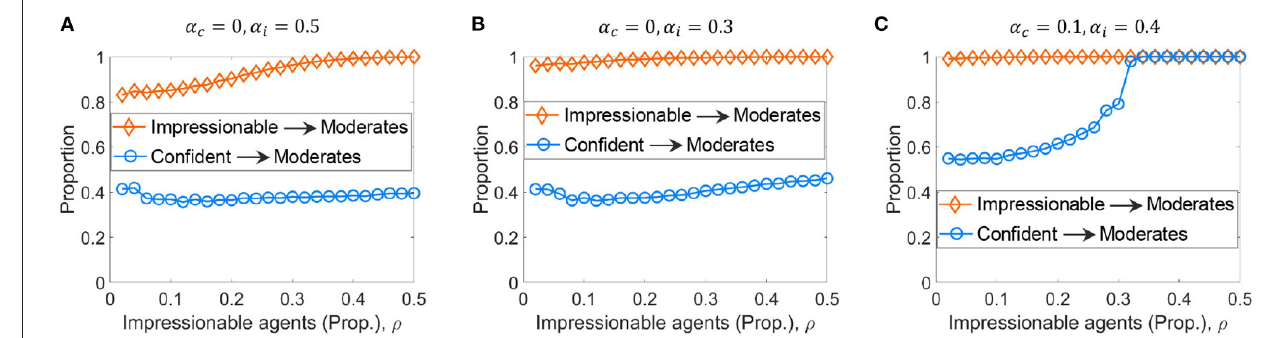
FIGURE 5 | Evolutionary relationship between impressionable/confident individuals and moderates. Three situations are considered: (A) α c = 0, α i = 0.5, (B) α c = 0, α i = 0.3, (C) α c = 0.1, α i = 0.4. In each situation, we present the proportion of impressionable individuals evolving to moderates (red diamond) and the proportion of confident individuals evolving to moderates (blue circle) with respect to changes in ρ . More than 80% of impressionable individuals finally hold moderate opinions in